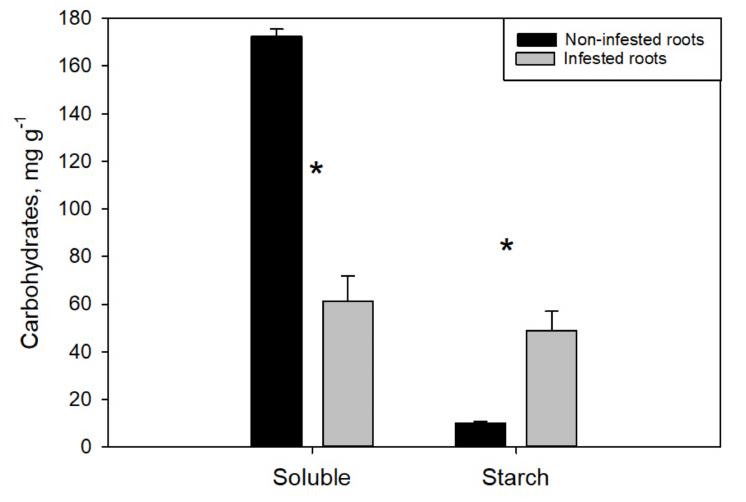
Figure 4. Soluble nonstructural carbohydrates and starch as measured in noninfested (black bars) and infested (grey bars) root tips sampled from both root and leaf infested plants (R + L) 56 days after inoculation. * indicates significant difference between groups (Student’s